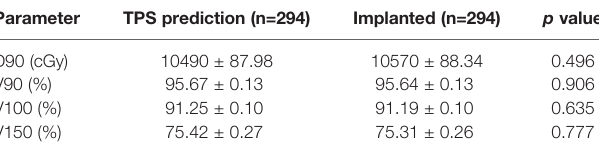
TABLE 2 | Comparisons of seed parameters between TPS prediction and implanted dose.